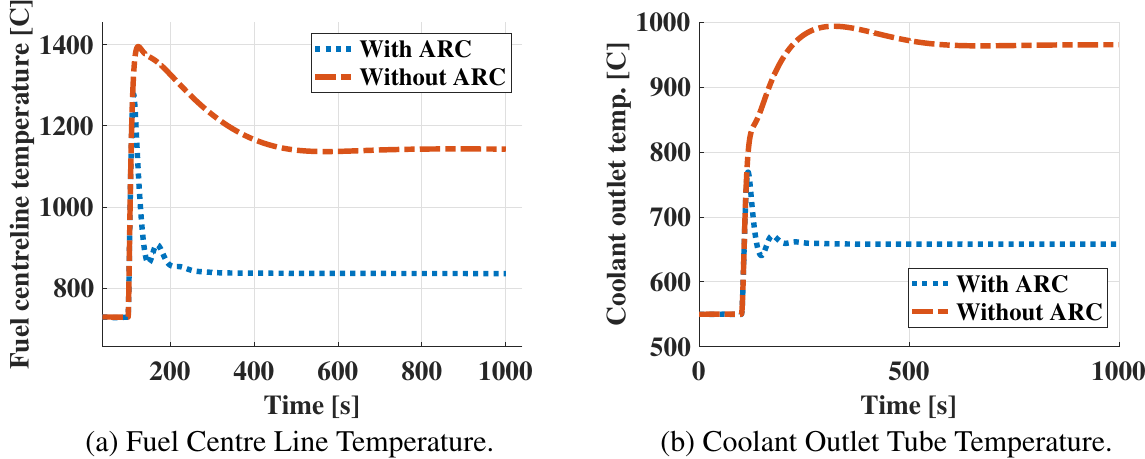
Figure 4: Temperatures during a UTOP (350 pcm in 1 s), with and without the ARC